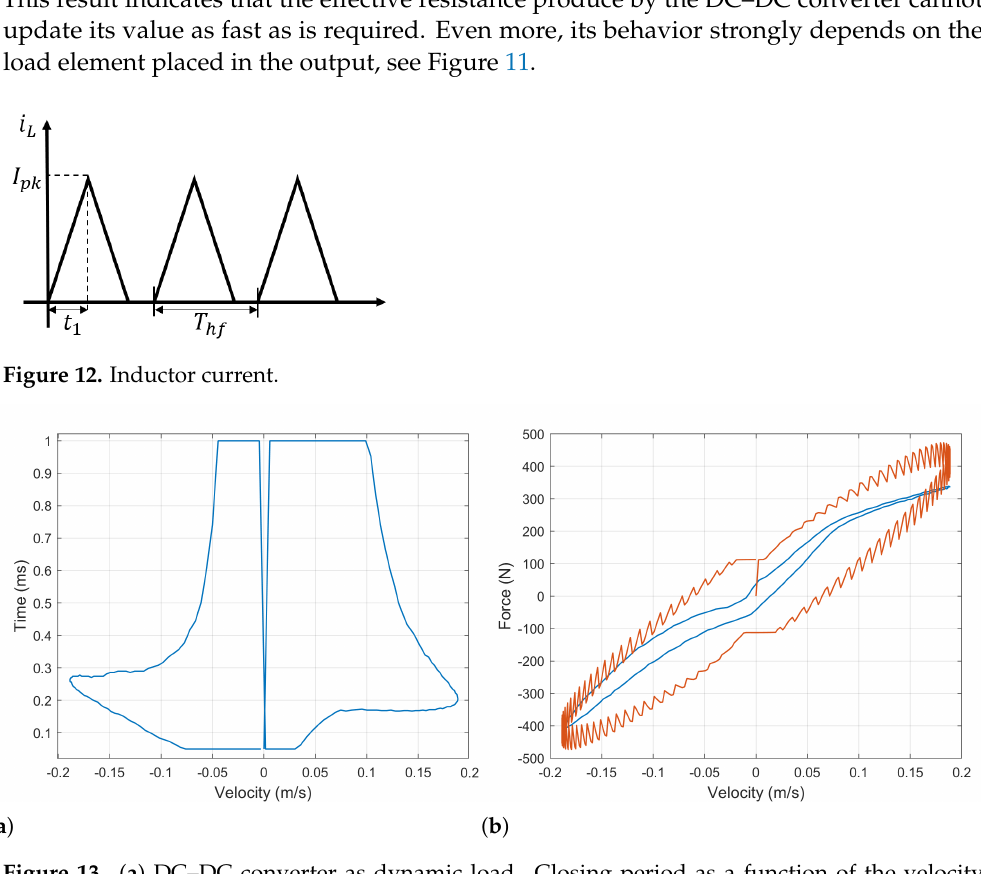
Figure 13. ( a ) DC–DC converter as dynamic load. Closing period as a function of the velocity. ( b ) DC–DC converter as dynamic load. Damping force produced by the BS-EHSA